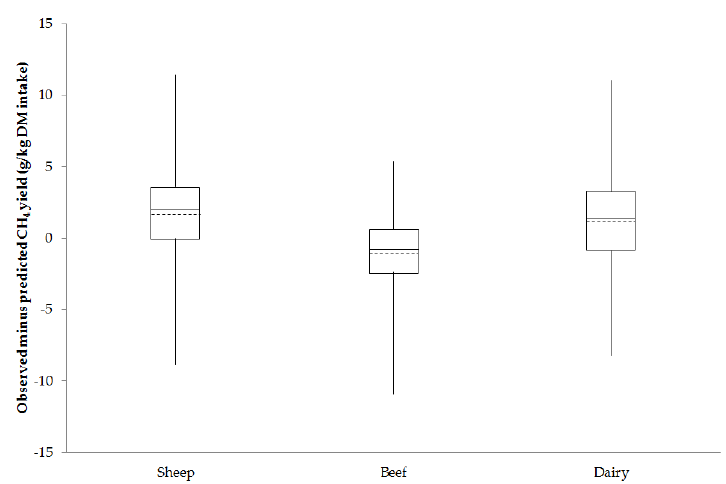
Figure 3. A box and whisker diagram showing the minimum, lower quartile, mean (- - -), median, upper quartile and maximum for observed minus predicted CH 4 yield (g/kg dry matter (DM) intake) across sheep, beef cattle and dairy cow data.